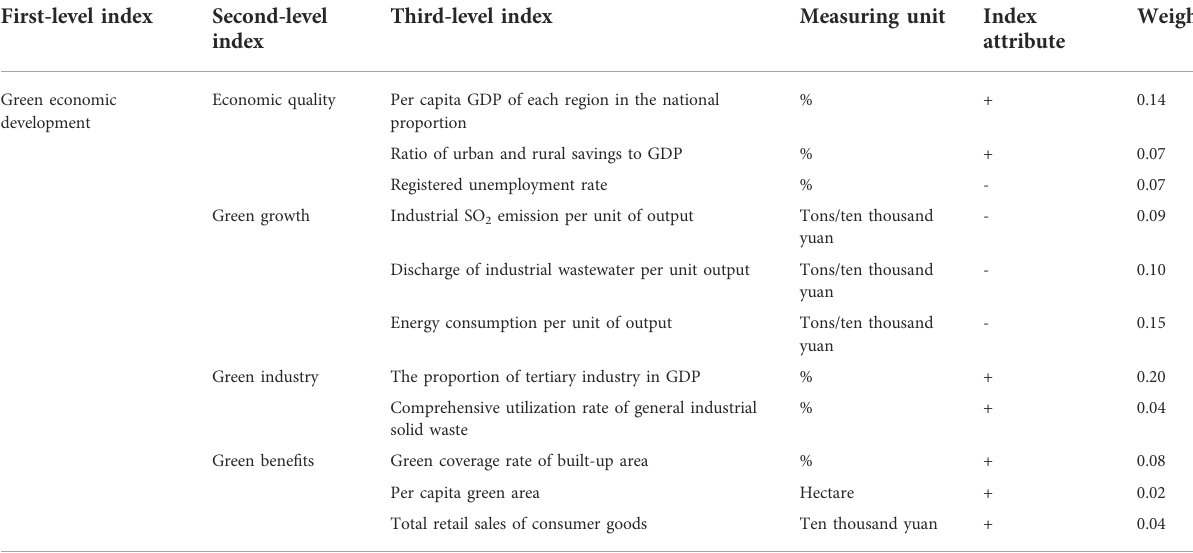
TABLE 1 The evaluation index system for green economic